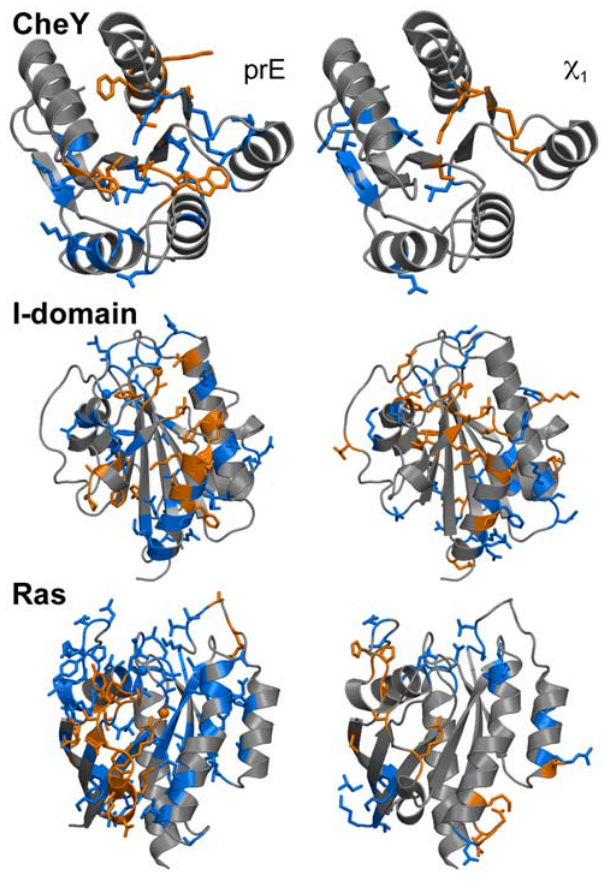
Figure 2. Contacts with large interaction energy differences or residues with large differences in their side chain dihedral angles. Differences between the crystal structures and the ensembles are mapped on to the three-dimensional structures of CheY, the a L I- domain, and Ras. Orange colored sticks indicate residues that make a state dependent contact (or have a state dependent side chain angle). Blue colored sticks reflect a contact (side chain) that differs between the two structures, but are not state